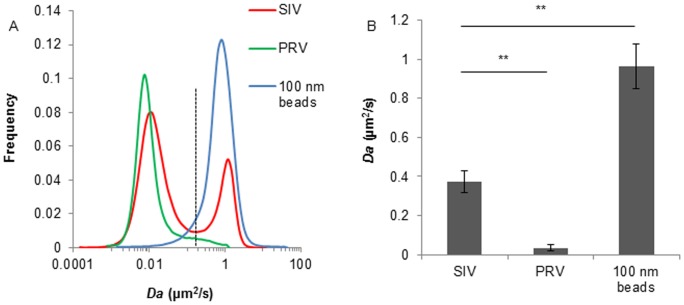
Diffusion coefficient of SIV in mucus and comparison with PRV and 100 nm PEGylated beads.(A) Distributions of the apparent diffusion coefficient of SIV, PRV and 100 nm PEGylated beads in porcine respiratory mucus. Trajectories of 8 steps were analyzed for each of the 1500 diffusion coefficients. Distributions were refined with MEM. Dashed line indicates the boundary of mobile and immobile diffusion. (B) Average diffusion coefficient of SIV, PRV and 100 nm PEGylated beads. Data were obtained from three independent experiments, and error bars indicate the standard deviation. The asterisks (**) indicate statistical significance (P<0.01, by Student’s t-test).